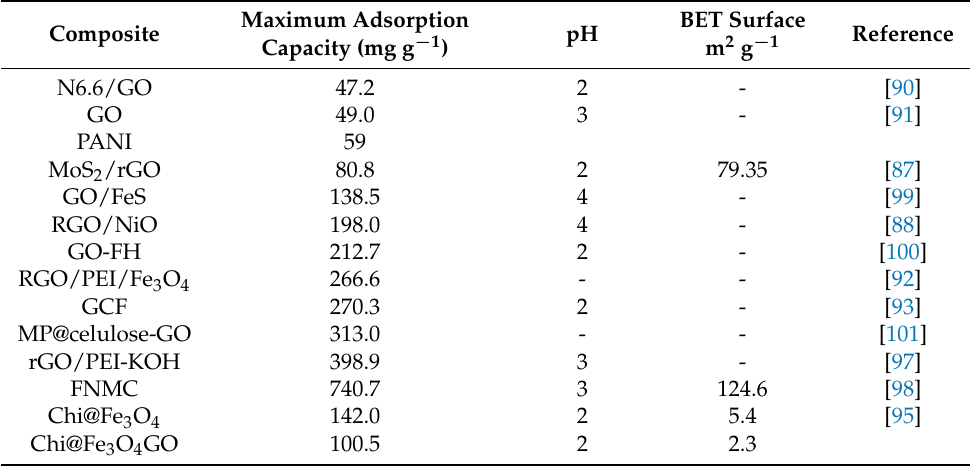
Table 3. Chromium adsorption on composites of